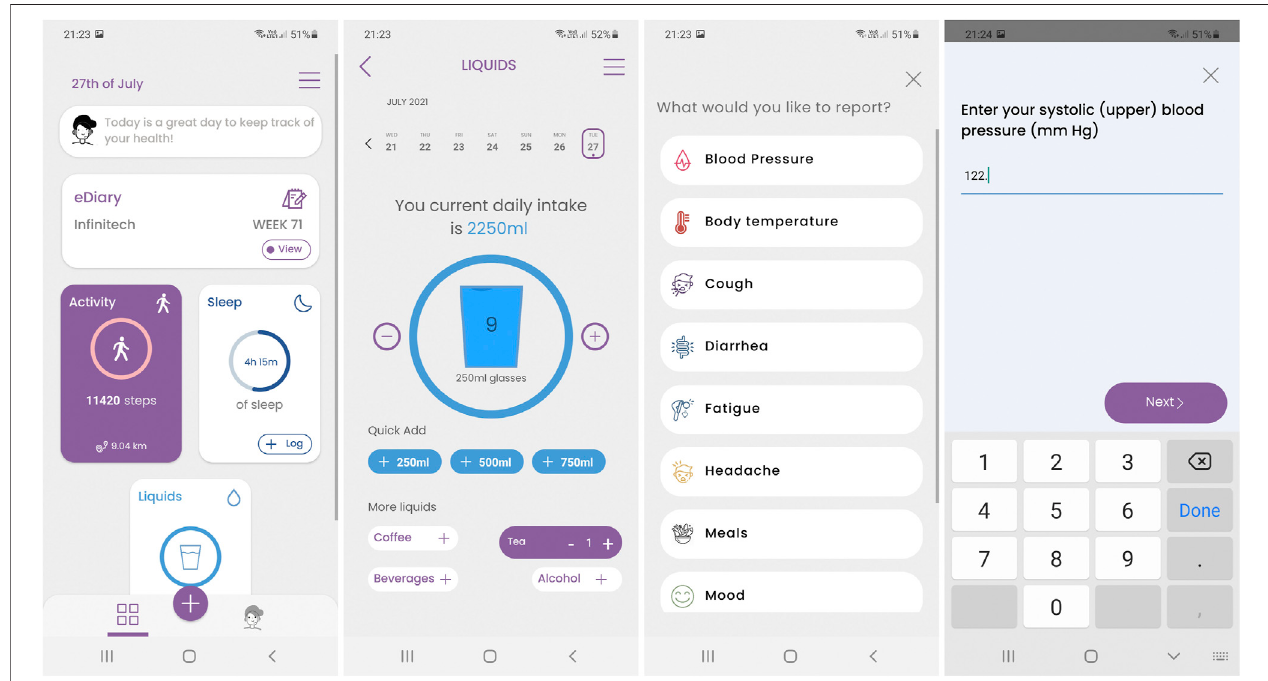
FIGURE 2 | Screenshots of the Healthentia mobile application, featuring from left to right the main screen with the data collection widgets, an example of the liquids ’ consumption widget, the symptom selector and a question being answered.